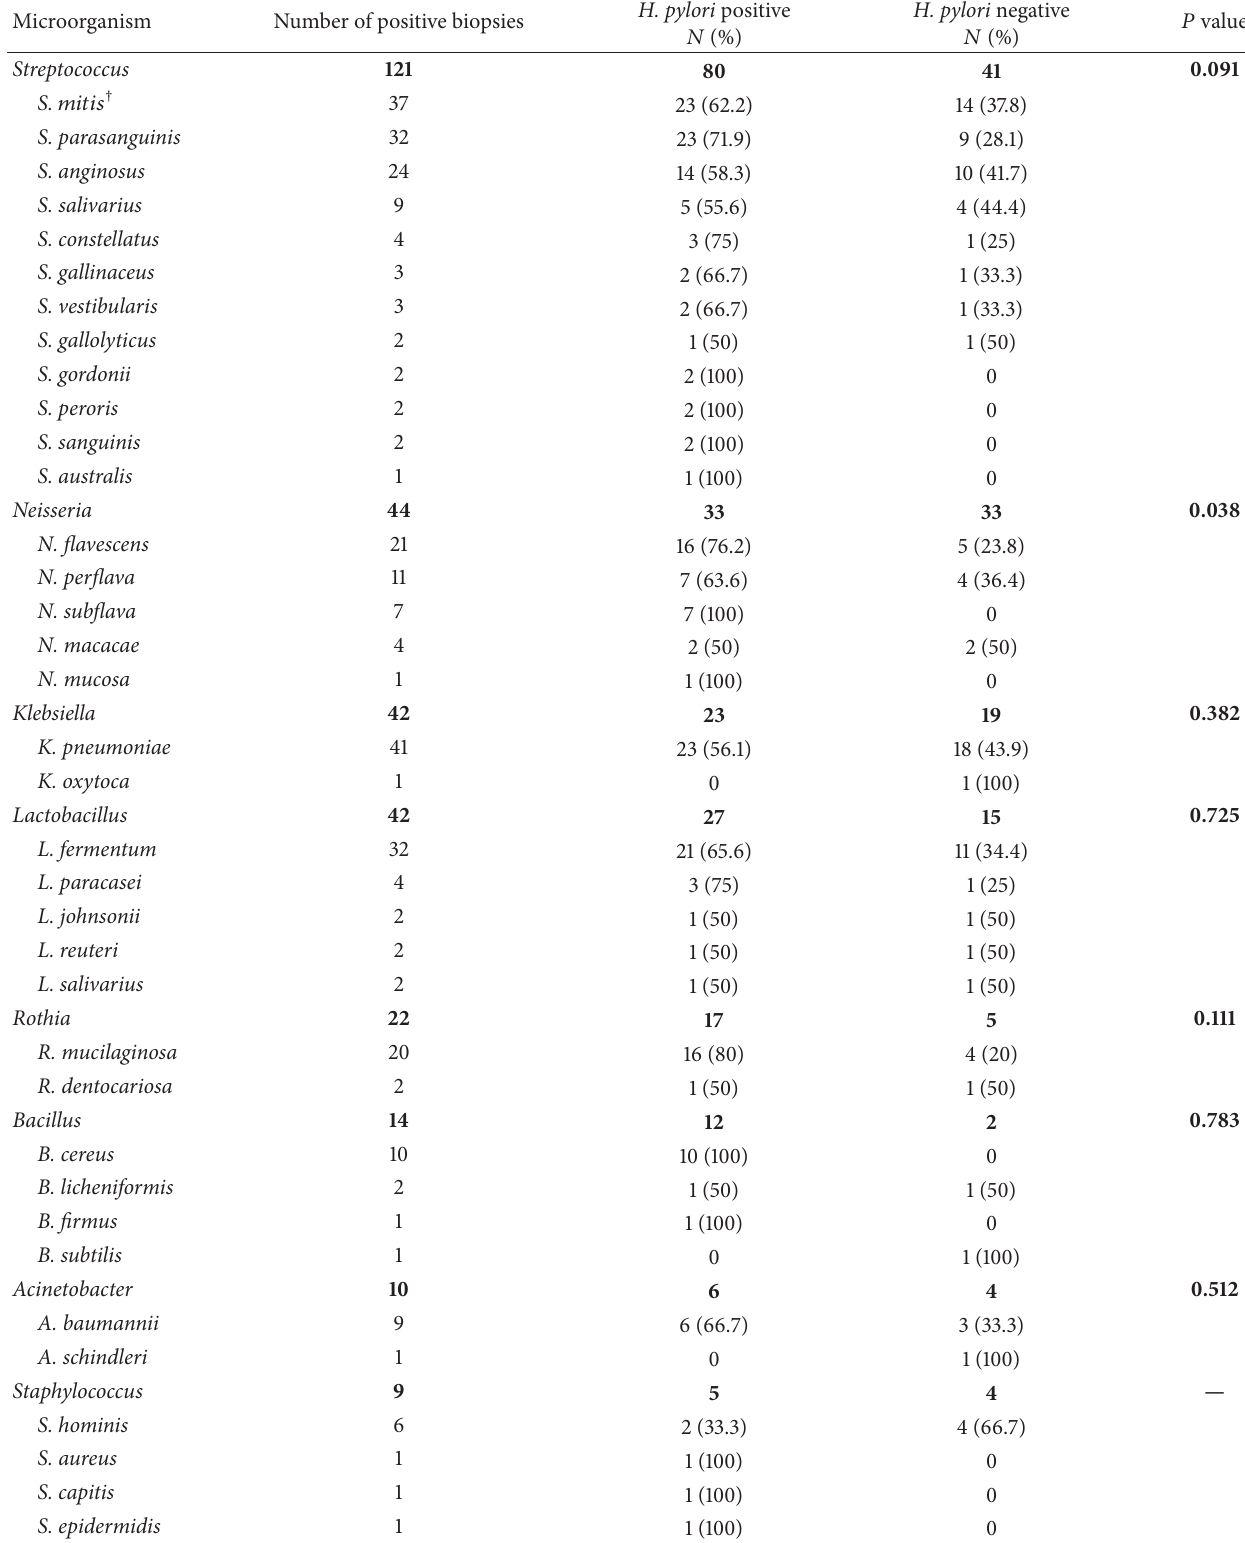
Table 2: Other microbial species identified by